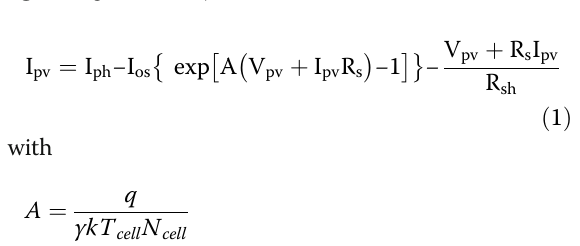
Fig. 2 Single diode equivalent model of the PV cell